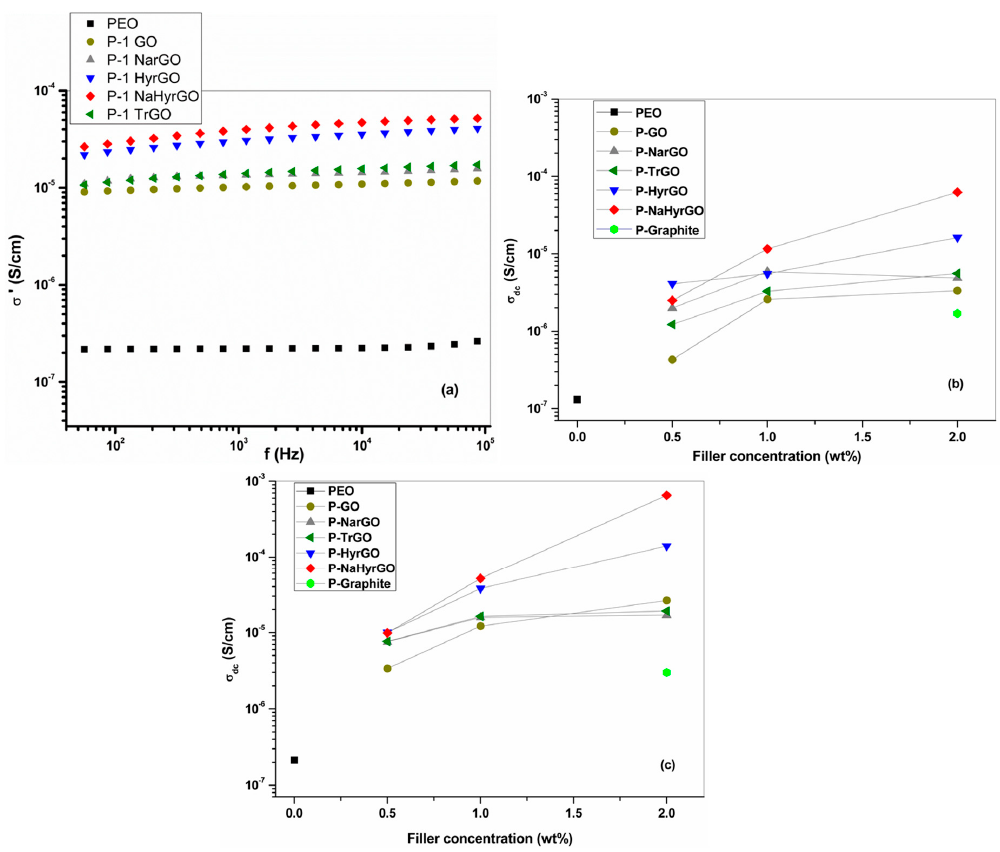
Figure 11. AC electrical conductivity (at 150 °C) of PEO-based nanocomposites with 1 wt % filler loading ( a ). ( b , c ) DC electrical conductivity ( σ dc ) versus filler concentration (wt %) for the nanocomposites at 100 and 150 °C.